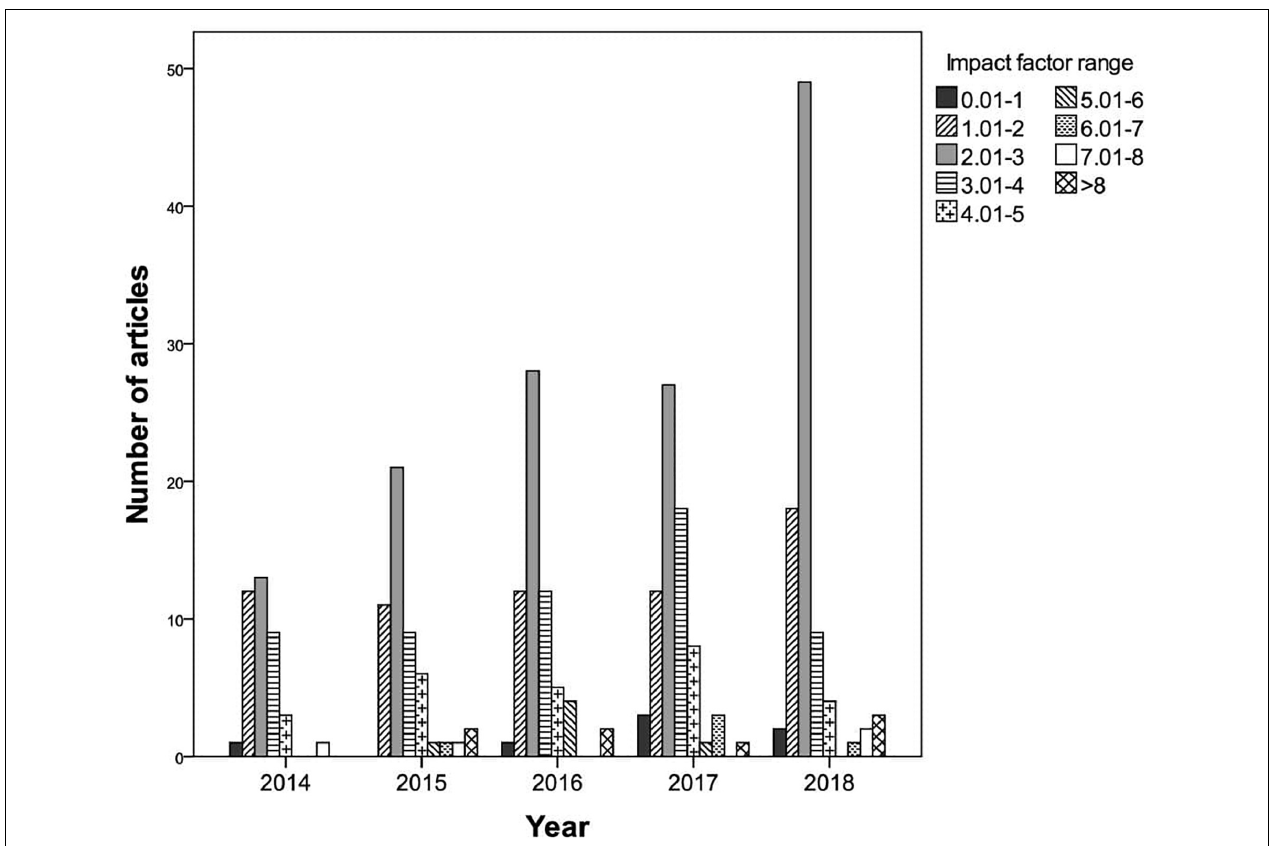
FIGURE 3 | Number of articles in each impact factor range by publication